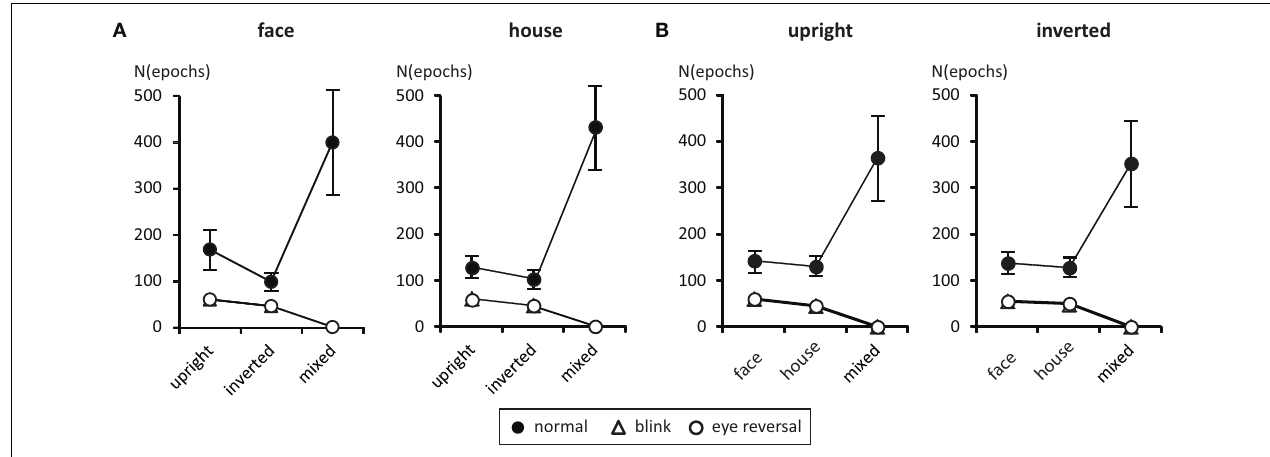
FIGURE 2 | Mean number of predominance epochs for upright faces and houses rivaling against their inverted counterparts (A), and faces rivaling against houses (B). Error bars indicate 95% confidence limits of the means.